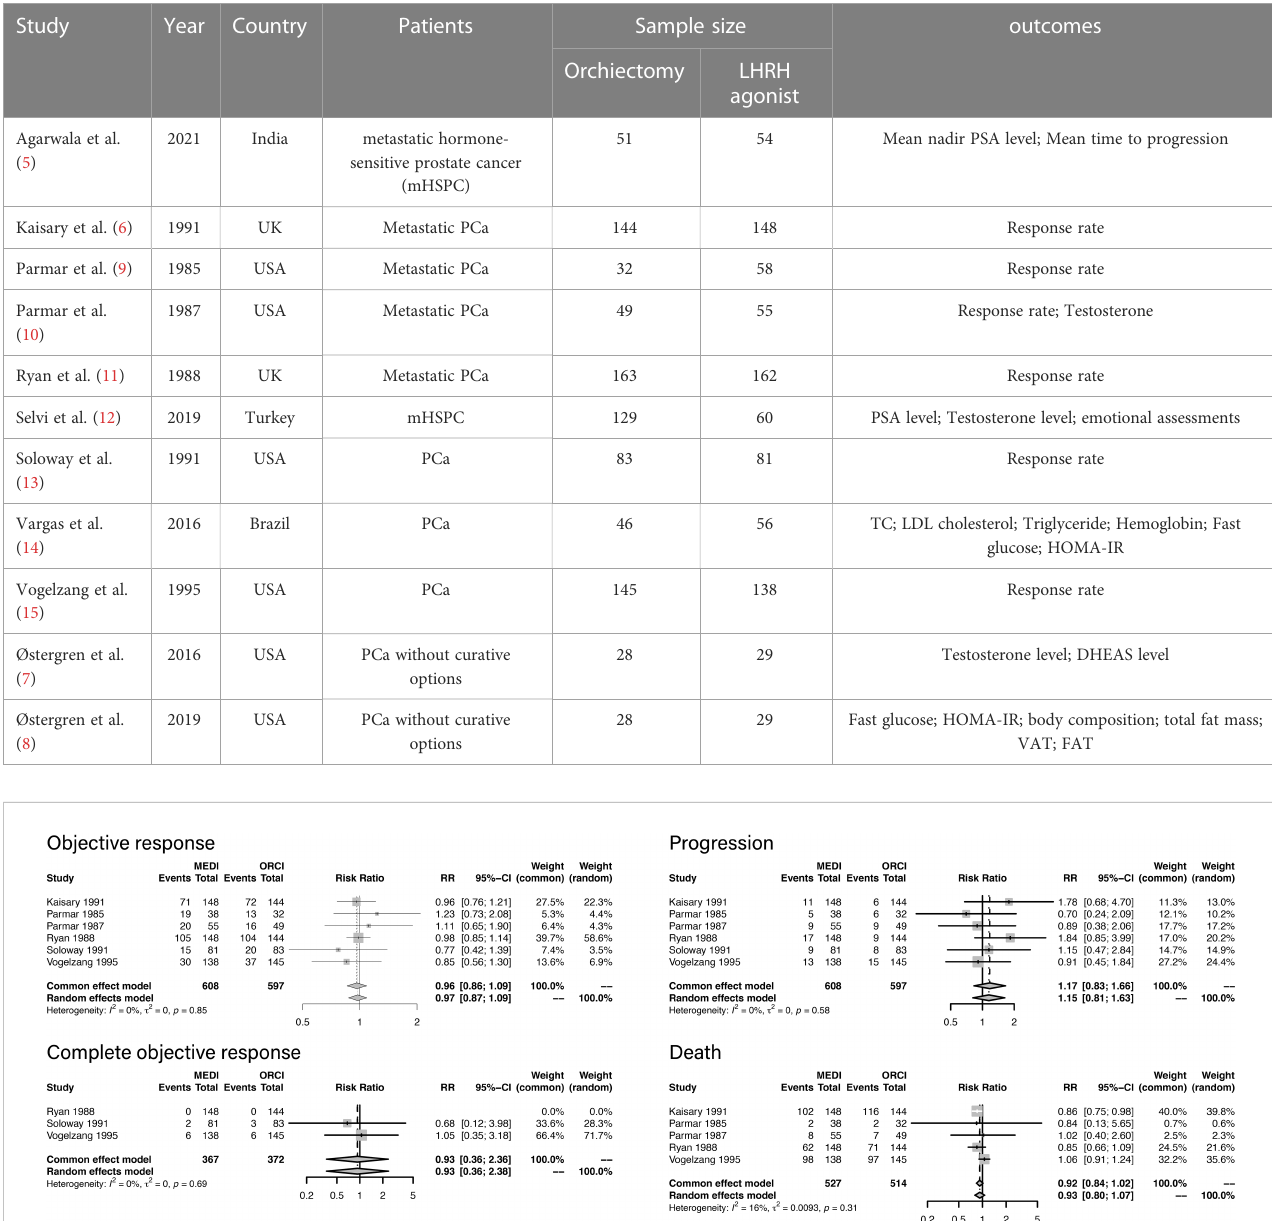
TABLE 1 Characteristics of included studies.